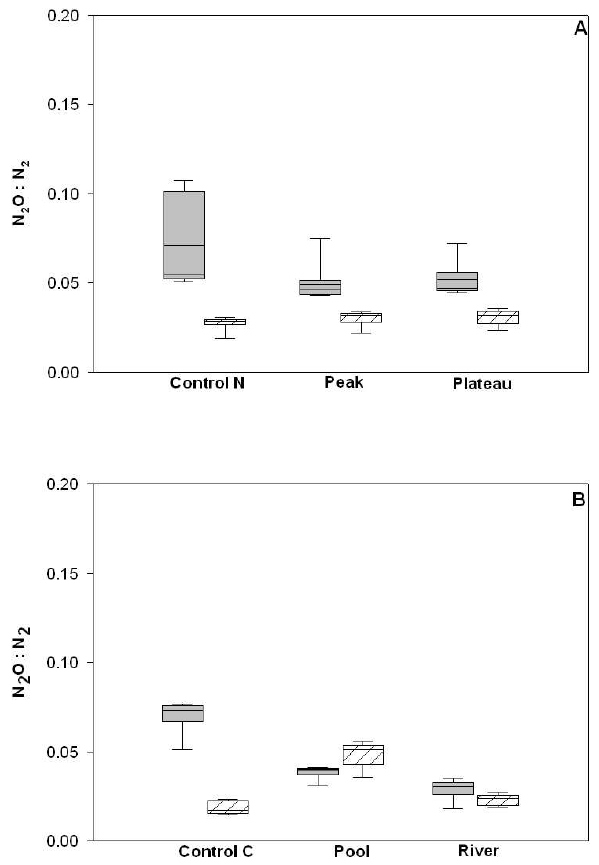
Fig. 4. Calculated N 2 O:N 2 ratios over the five-day incubation from (A) Experiment 1: NO − and (B) Experiment 2: DOM changes. Figure 4. Calculated N 2 O:N 2 ratios over the 5 day incubation from (A) Experiment 1: NO 3- and 3 Grey boxes are measurements from the disconnected site, hatched (B) Experiment 2: DOM changes. Grey boxes are measurements from the disconnected boxes from the restored site. Whiskers extend to the 95th and 5th site, hatched boxes from the restored site. Whiskers extend to the 95th and 5th percentiles. N = percentiles. N=33